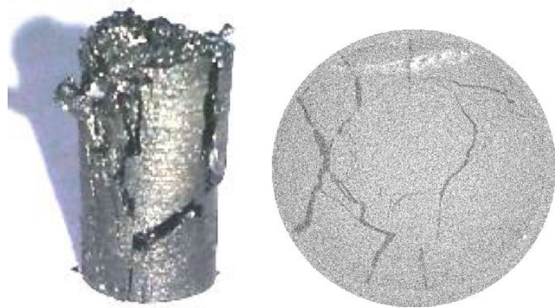
Figure 10: The fractured coal